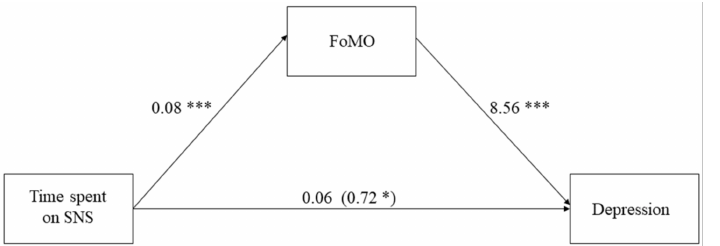
Figure 2. FOMO as mediator in the relation between Time spent on SNS and Depression. Note: p < 0.001 ***, p < 0.05